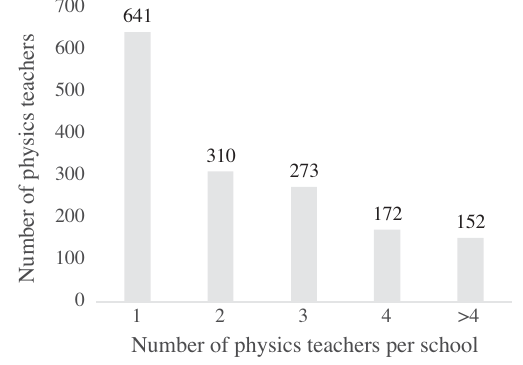
FIG. 2. Number of physics teachers in schools that taught physics.